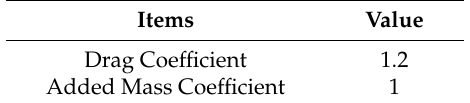
Table 5. Drag and added mass coefficients for the pipeline dynamic